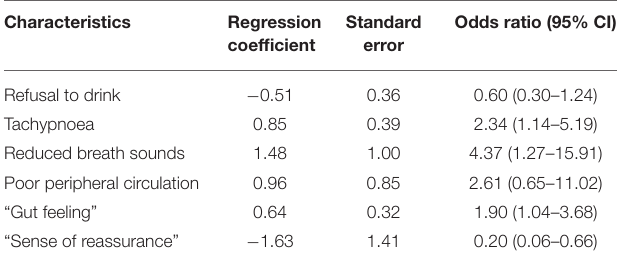
TABLE 5 | Variables of clinical prediction model 2. Characteristics